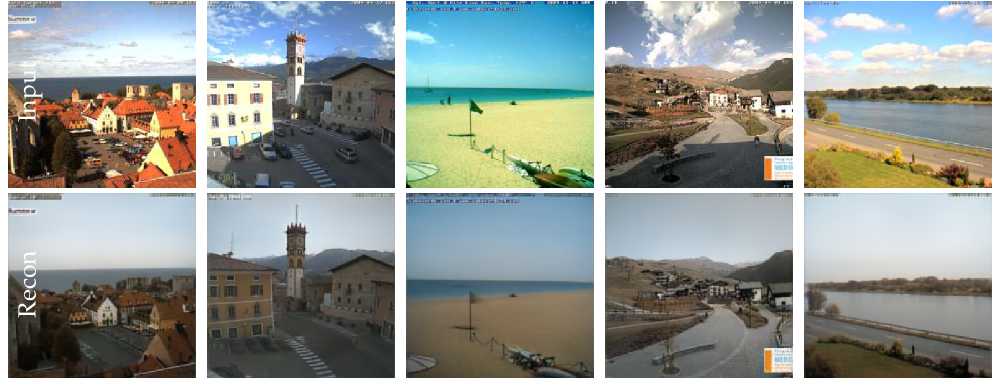
Figure 8. Examples for the Webcam Clip Art dataset. The encoder–decoder model removes the environmental features from the images ( first row ) to form the output images ( second row ). Vehicles and people are removed from the scenery and skies, rivers and beaches are smoothed out.